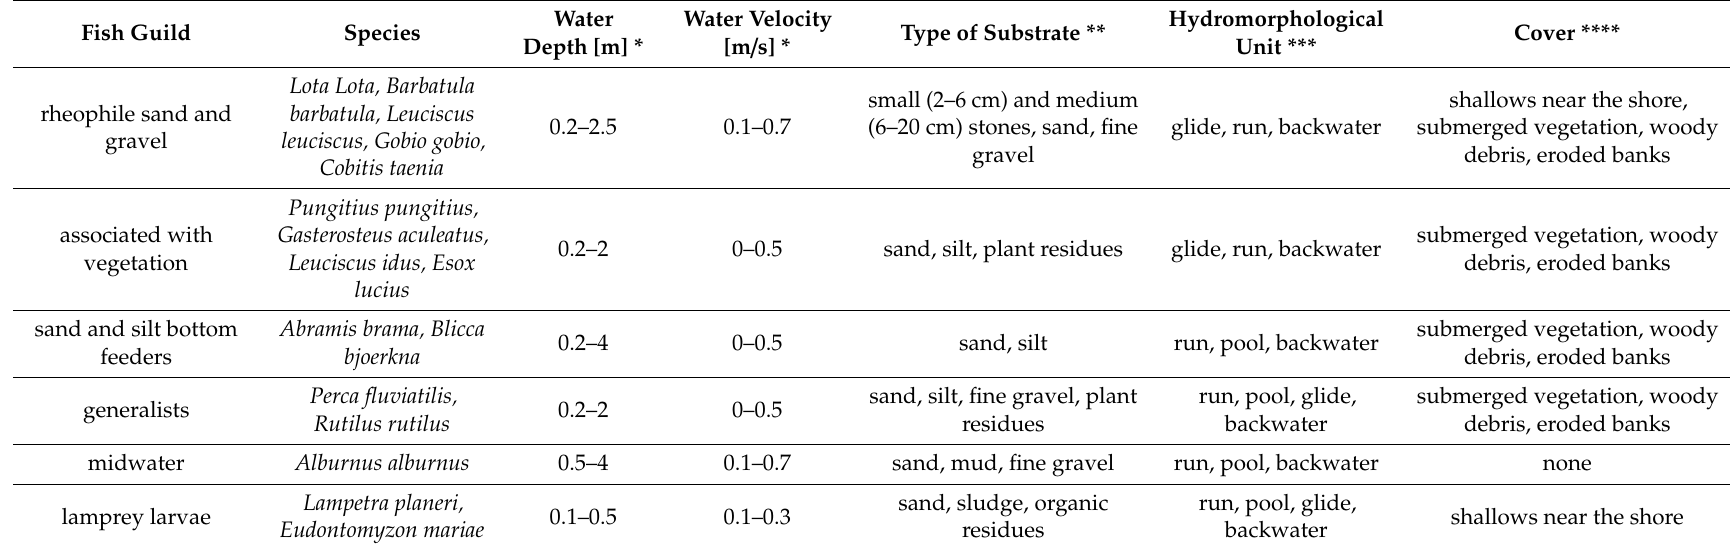
Table 1. Fish guilds and habitat